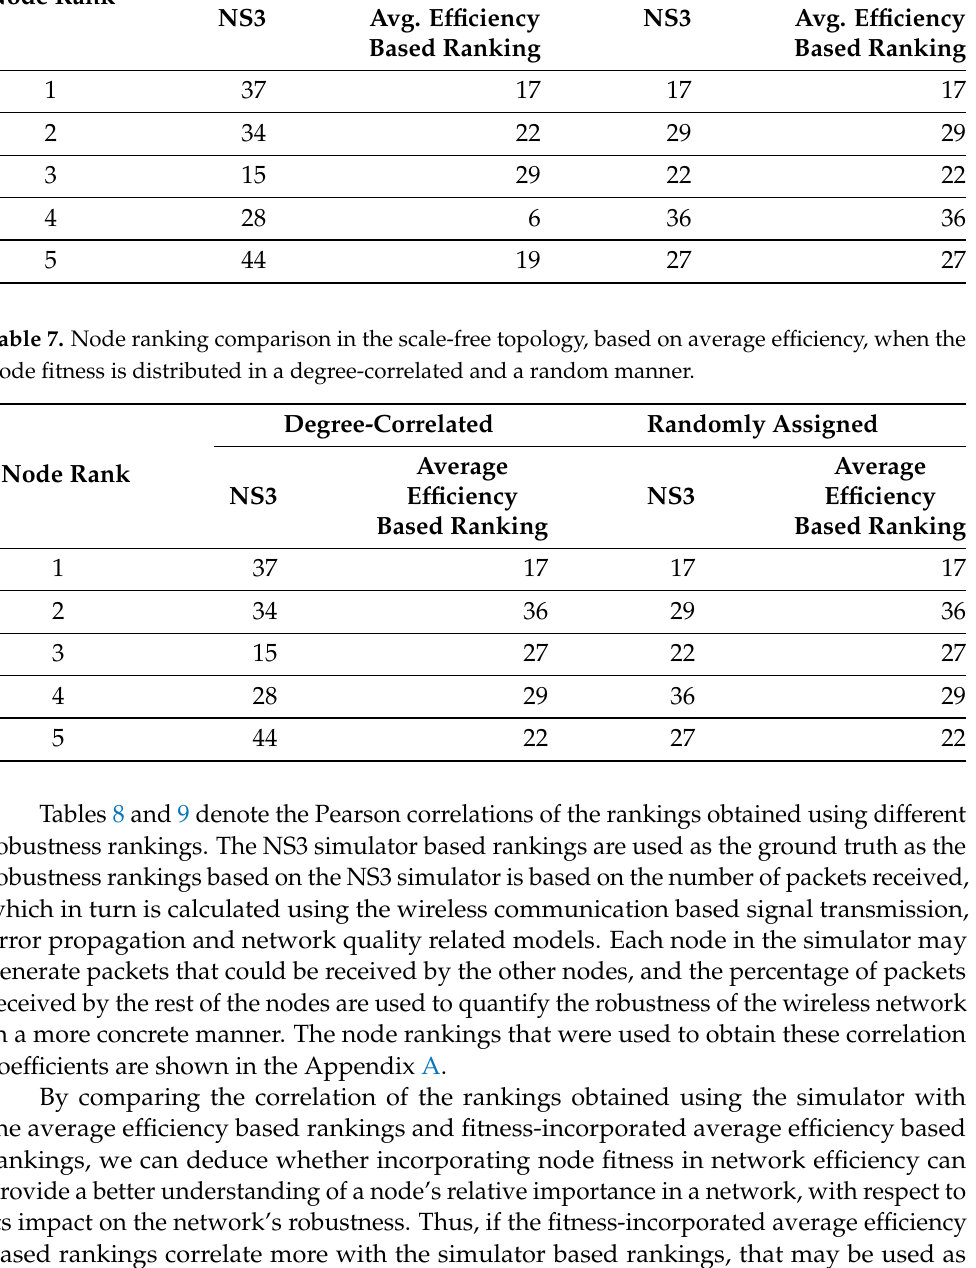
Table 6. Node ranking comparison of scale-free topology, based on fitness-incorporated average efficiency, when the node fitness is distributed in a degree-correlated and a random manner. Degree-Correlated Node Rank